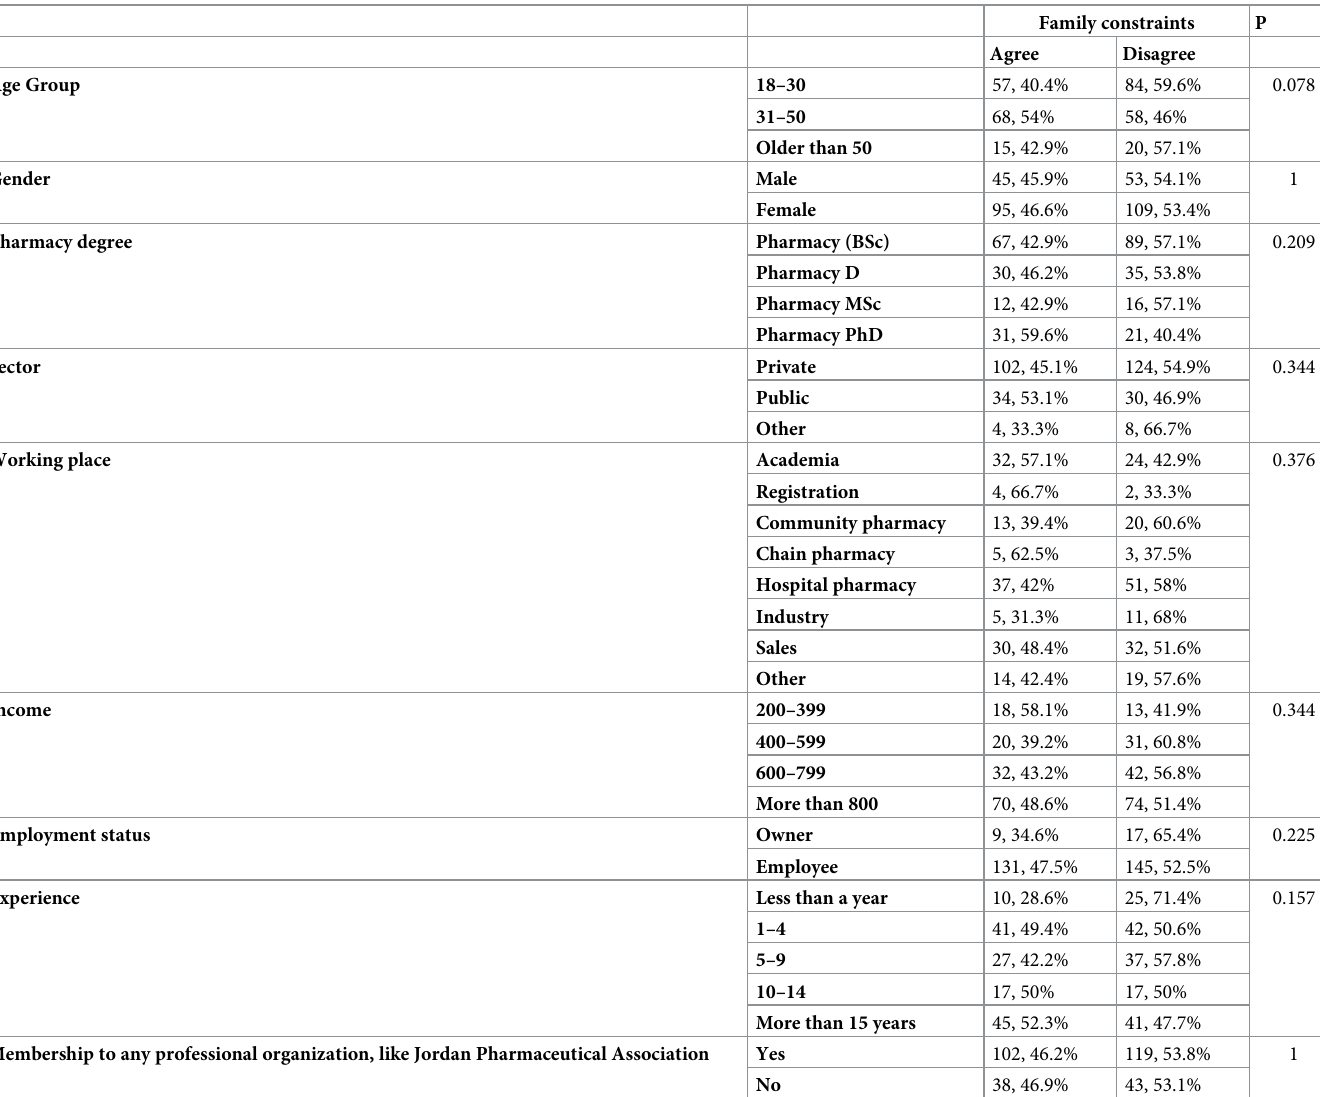
Table 3. Comparison based on family constraints for the whole